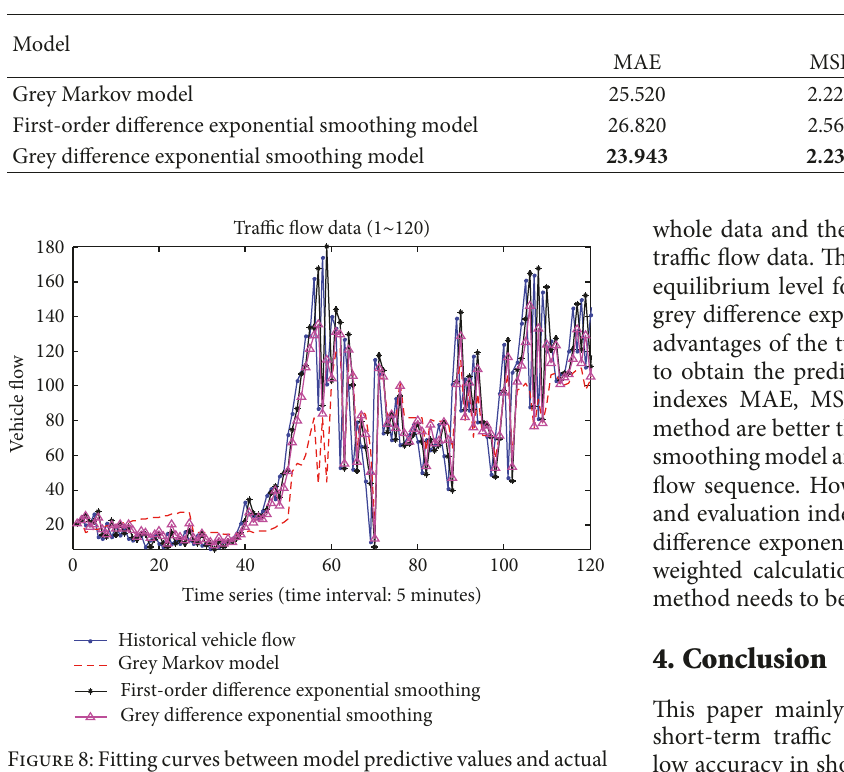
Table 2: Evaluation index of forecasting model.